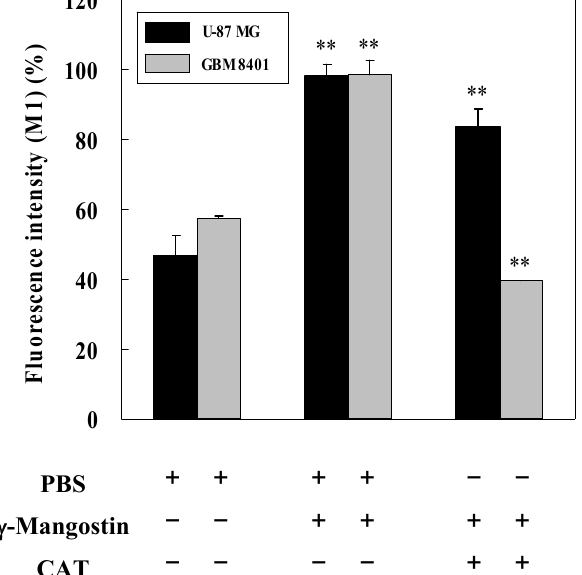
Figure 6. Catalase (CAT) prevented potential γ -mangostin-induced mitochondrial membrane dysfunction. (A) Cells were treated with γ -mangostin (80 μ M) for 1 hour with or without prior treatment with CAT (400 U / mL) or PBS for 3 hours. At the end of the incubation, the mitochondrial membrane potential was analyzed by adding DiOC fluorescent substrate on flow cytometric analysis. (B) To quantity data of the M1 region which is a half of control group as well as γ -mangostin induced mitochondrial dysfunction was derived from three independent experiments, and those results were presented as the mean ± SD. * p < 0.05 and ** p < 0.01 indicate significant differences from the control group as analyzed by Student’s t